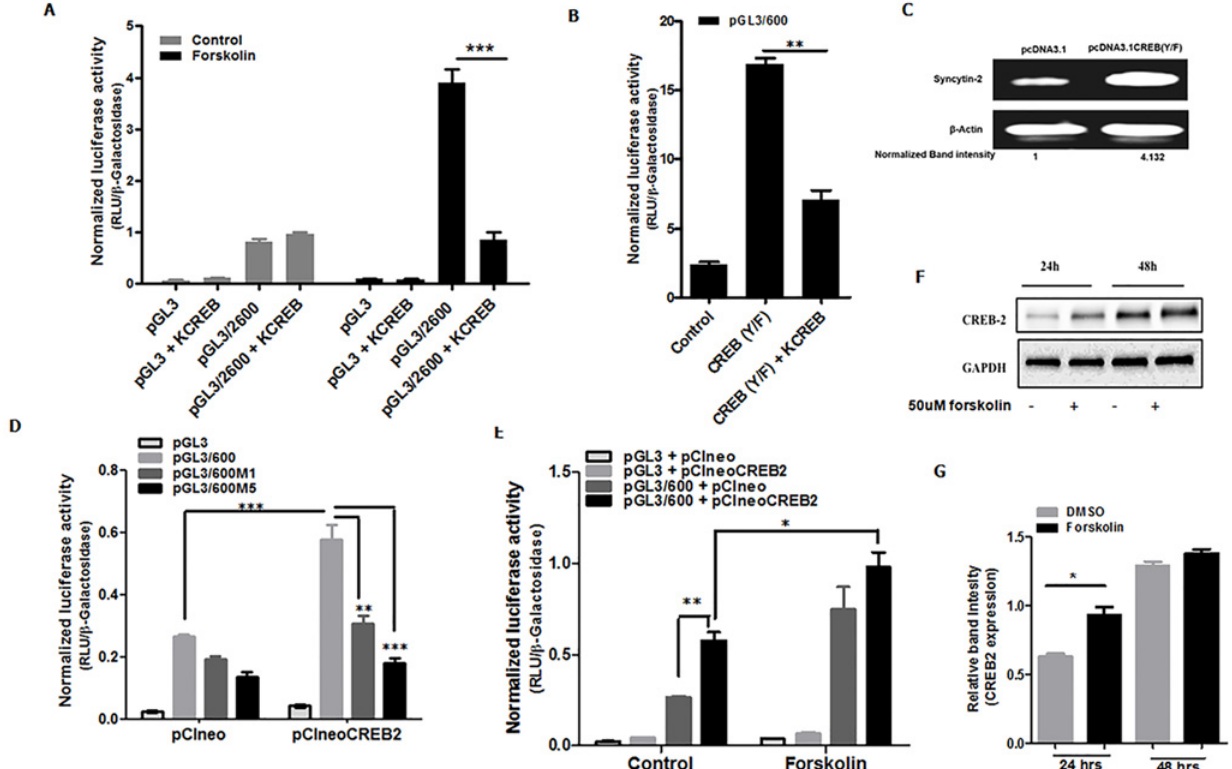
Fig 5. CREB2 induces activation of the Syncytin-2 promoter. (A) BeWo cells were co-transfected with pGL3/2600 (200 ng) (or pGL3basic), KCREB, a CREB dominant-negative mutant expression vector (vs. control vector) (200 ng) and pRcActin-LacZ (200 ng). At 36 h post transfection, cells were either left untreated (Control) or treated with forskolin. After 12 h of treatment, cells were harvested and analyzed for luciferase activity in triplicates. Luciferase activities were normalized over β -galactosidase activity and are expressed as the mean normalized RLU ± S.E.M. from three independently transfected cells in the same experiment. Results are representative of three independent experiments. (B) BeWo cells were co-transfected with pGL3/600 (200 ng), the constitutively activated CREB (Y/F) expression vector (200 ng), the CREB dominant-negative mutant expression vector (200 ng) (vs. control vector) and pRcActin-LacZ (200 ng). At 48 h post-transfection, cells were harvested and assayed for luciferase activity. Luciferase activities were normalized over β - galactosidase activity as the mean ± S.E.M. from three independently transfected cells in the same experiment. Results are representative of three independent experiments. (C) BeWo cells were transfected with the CREB (Y/F) expression vector (vs. the control empty vector) (200 ng). At 48 h post- transfection, total RNA were extracted and analyzed by RT-PCR for both Syncytin-2 and β -actin mRNA. Band intensities of Syncytin-2 mRNA after normalization with β -actin mRNA levels are indicated below with values for pcDNA3.1-transfected cells set as 1. ( D-E ) BeWo cells were co-transfected with pGL3/600 (400 ng) or equivalent constructs bearing the M1 or M5 mutant ( D ) along with pCIneoCREB2 (or the empty vector pCIneo) and pRcActin-LacZ (200 ng). In ( E ), cells were either left untreated or treated with forskolin prior to lysis. Luciferase activities were normalized over β -galactosidase activity as the mean ± S.E.M. from three independently transfected cells in the same experiment. Results are representative of two independent experiments. ( F-G ) BeWo cells were treated or not with forskolin for 24 and 48 h and cell extracts were subsequently analyzed for CREB2 and GAPDH protein levels by Western blot. Band intensities for CREB2 are depicted in ( G ) following normalization with GAPDH signals and were calculated as the mean ratio ± S.E.M. from three independent experiments ( * p < 0.05; ** p < 0.01; *** p <